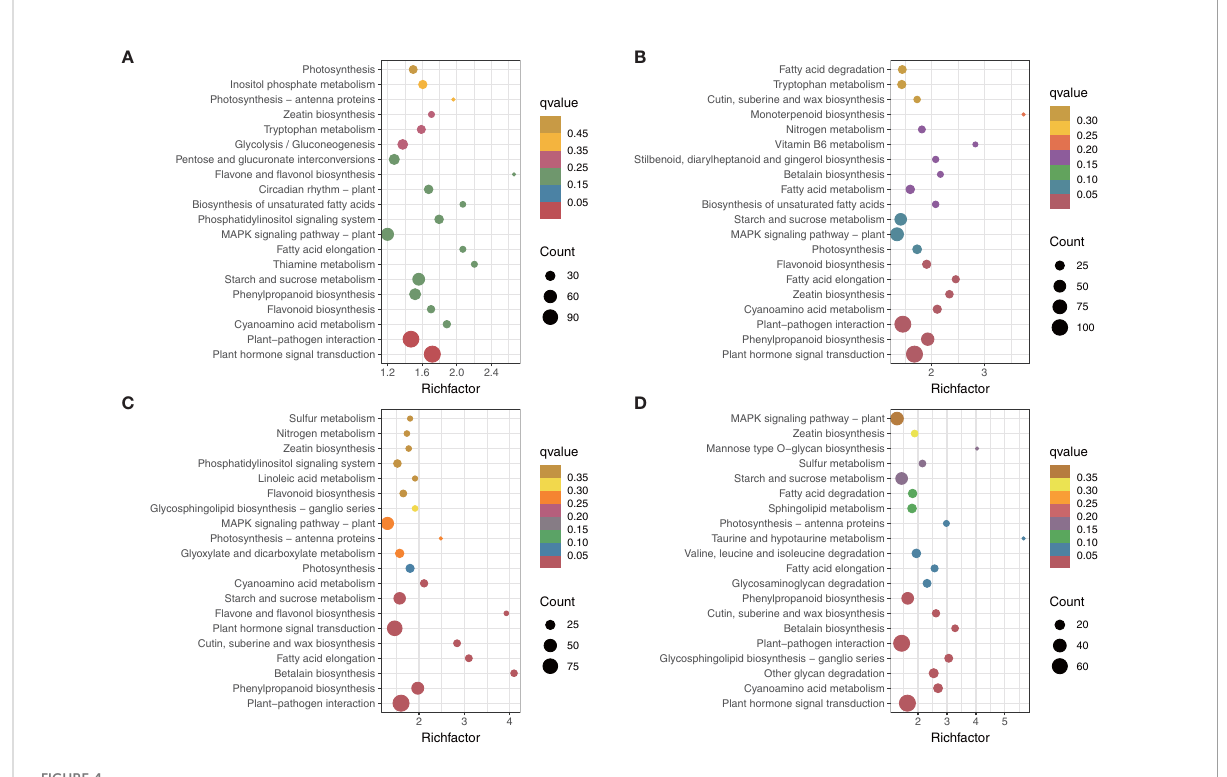
FIGURE 4 KEGG enrichment analysis of different comparisons. (A) NC vs AC. (B) NL vs AL. (C) NP vs AP. (D) NS vs